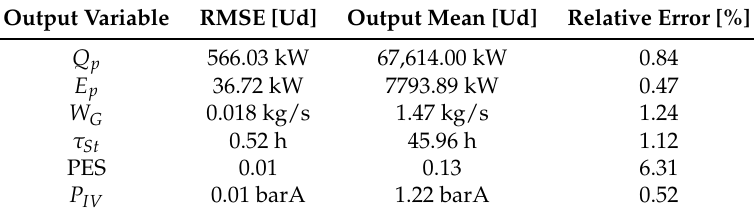
Table 2. Indexes for the output variables of the